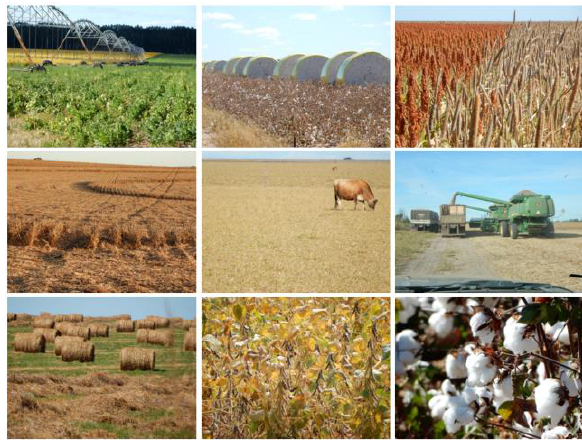
Figure 2. Photographs taken during the first field campaign in LEM municipality (26-30th June 2017).